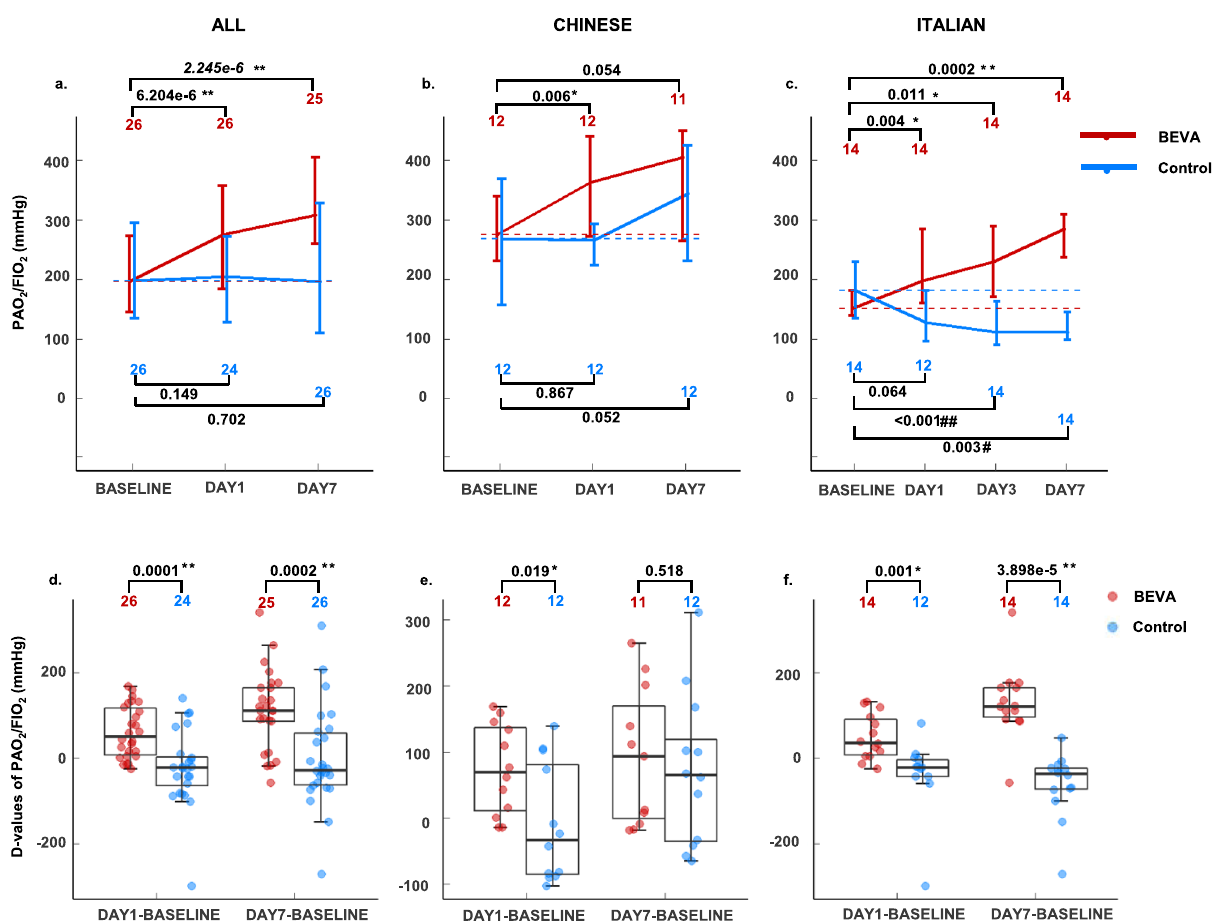
Fig. 2 Comparison of dynamic changes of PaO 2 /FiO 2 between BEVA (bevacizumab) and control groups. PaO 2 /FiO 2 values in all patients ( a ), Chinese ( b ), and Italian ( c ) groups. The dashed lines represent the baselines; nodes in the lines represent the median values; the lower and upper values of the bar correspond to the 25th and 75th percentiles (Q1 and Q3); the length of the bar represents the interquartile range (IQR); red and blue numbers correspond to the sample sizes ( n ); numbers on the horizontal lines represent p -values. D -values (the difference values between days 1 or 7 and baseline) of individual patients were utilized for the comparisons between BEVA and control groups of all patients ( d ), Chinese ( e ), and Italian ( f ) patients. The center lines of boxes represent median values; the lower and upper hinges represent Q1 and Q3, the range between which represents IQR; whiskers correspond to the highest or lowest values of non-outlier data (within 1.5 × IQR from the lower or upper hinges); numbers on the horizontal lines represent p- values; red and blue numbers correspond to the sample sizes ( n ); the red and blue dots represent the data of individual patients. For a – c , p -values were calculated by Wilcoxon matched-pairs signed-rank test. For d – f , p- values were calculated by Wilcoxon signed-rank test. PaO 2 /FiO 2 partial arterial oxygen pressure to fraction of inspiration O 2 ratio. p < 0.05 for two-tailed hypothesis tests was considered statistically signi fi cant. Source data are provided as a Source Data fi